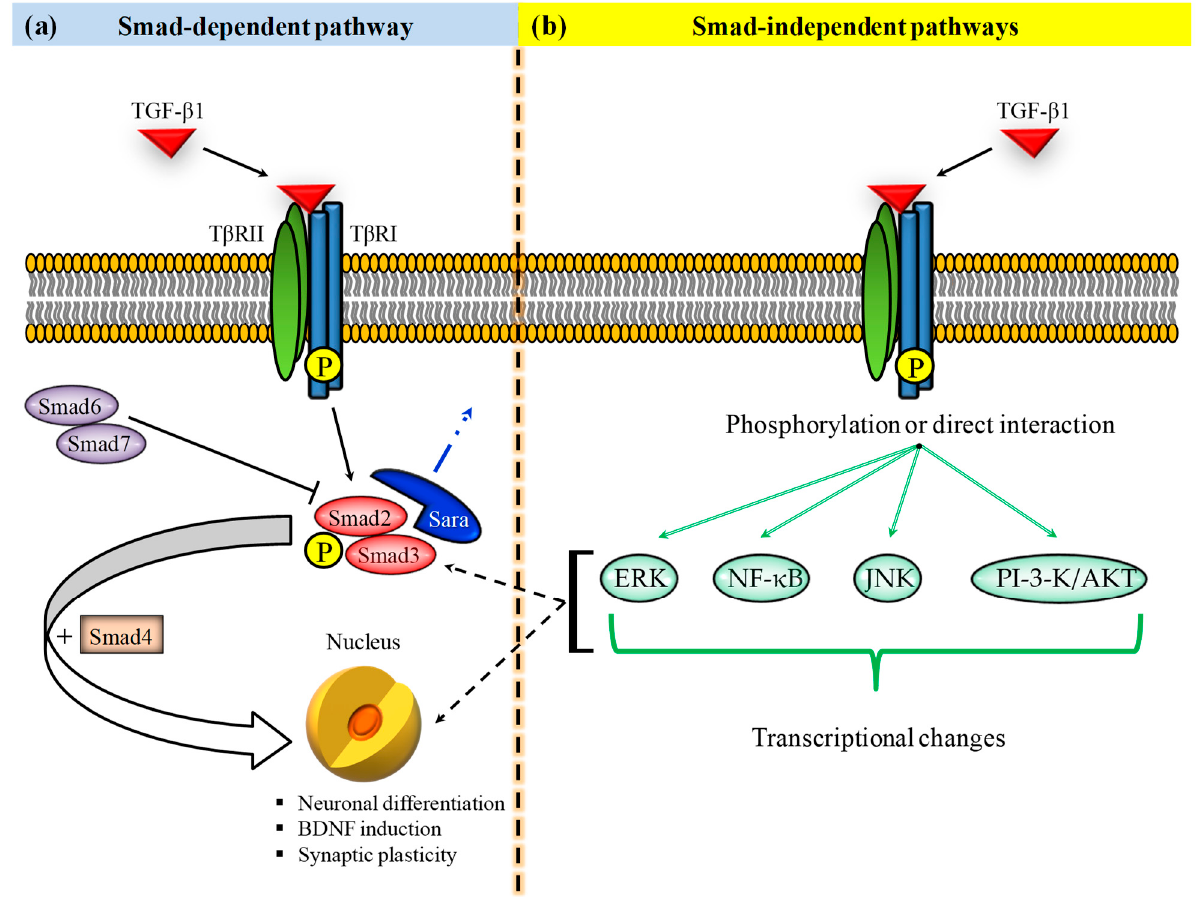
Figure 1. (a) Smad-dependent and (b) Smad-independent TGF- β 1 signaling pathways are involved in the regulation of various cellular processes, including cell growth/proliferation, differentiation, cell migration, invasion, and extracellular matrix remodeling. (a) TGF- β 1 binds to the T β RII homodimers allowing the dimerization with T β RI homodimers, the activation of the kinase domain of TGF- β RI kinase domain, and the phosphorylation of both SMAD2 and SMAD3. These phosphorylated proteins interact with SMAD4 leading to the formation of a heterotrimeric complex able to translocate into the nucleus with the subsequent activation or repression of different genes involved in neuronal homeostasis. (b) TGF- β 1 can also recruit Smad-independent signaling pathways such as ERK, NF- κ B, JNK, and PI-3-K/AKT. These non-Smad transducers can mediate signaling responses alone or in combination with Smads, also converging onto Smads to control Smad activities. P indicates phosphorylation. T β RII = TGF- β type II receptor; T β RI = TGF- β type I receptor; BDNF = brain-derived neurotrophic factor; Sara = Smad anchor for receptor activation; NF- κ B = nuclear factor kappa-light-chain-enhancer of activated B cells; ERK = extracellular signal-regulated kinase; PI-3-K = phosphatidylinositol-3-kinase; JNK = c-Jun amino terminal kinase.